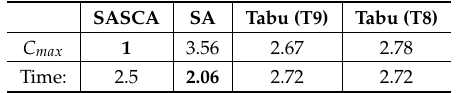
Table 6. Results of Friedman test for the small problems (best results are in boldface).